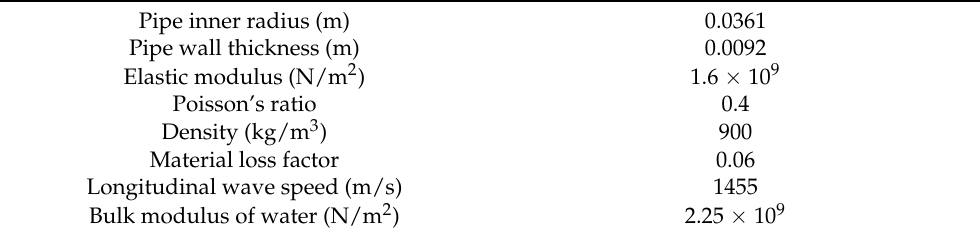
Table 1. Geometric and material properties of the MDPE pipe.